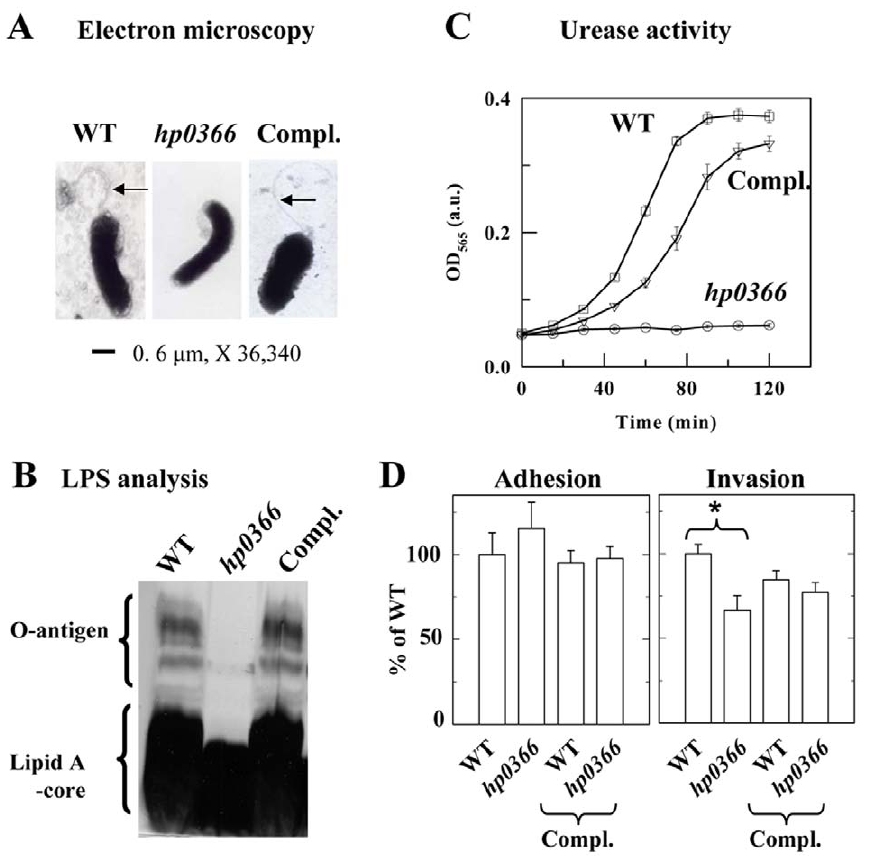
Figure 2. Impact of disruption of hp0366 on virulence factor production and interactions with gastric cells. Panel A: Analysis of flagellum production by electron microscopy. Arrows point at flagella. Panel B: Analysis of LPS production. LPS was extracted from the WT, mutant and complemented strain (Compl.) and analyzed by SDS-PAGE and silver staining. Panel C: Analysis of the urease activity of WT, mutant and complemented (Compl.) H. pylori . Urease activity was measured using phenol red as an indicator [92]. Experiments were done with 3 different concentrations of soluble protein extracts and the same trend was observed. The data shown were obtained with the highest amount of protein tested and are the average of three replicas. Panel D: Adherence and invasion of H. pylori WT, mutant and complemented strains to gastric AGS cells. The data are expressed in % of adherence or invasion of WT H. pylori . The data are the average of 3 independent experiments. Compl. indicates that the wild-type hp0366 gene was introduced in the strain of interest on a shuttle plasmid. The adherence of WT amounted to 8–10% of the inoculum. No statistical differences (t-test) were observed between WT and mutant strain for adherence. Invasion was measured after elimination of non- internalized bacteria by gentamycin treatment. Invasion represented , 1.5% of the inoculum for the WT. Statistical differences were observed between the WT and mutant (shown by asterisk, t-test, p , 0.001).